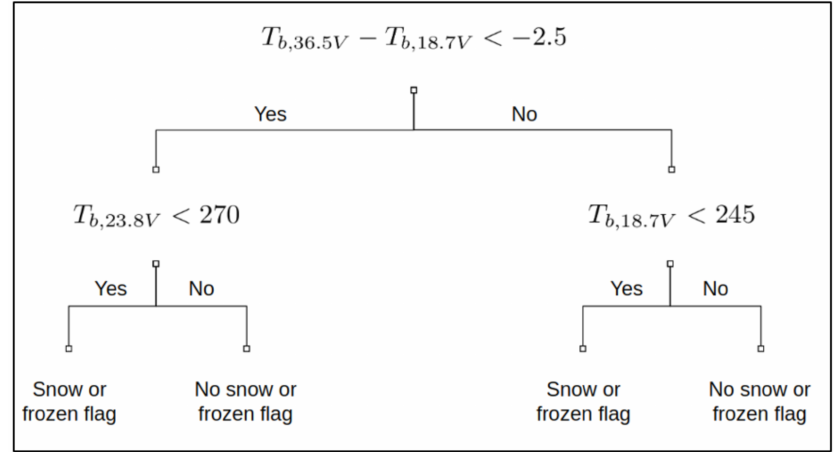
Figure 4. Decision tree of the snow / frozen flag based on the vertical 18.7 GHz, 23.8 GHz, and 36.5 GHz brightness temperatures (respectively T b ,18.7 V , T b ,23.8 V , and T b ,36.5 V